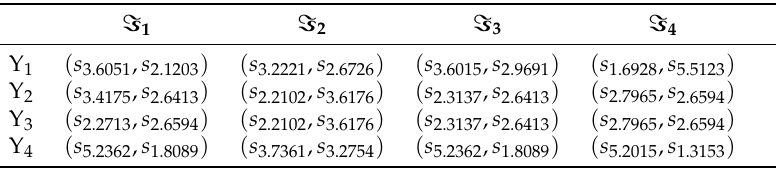
Table 9. Decision matrix by using LPFOWG operators.